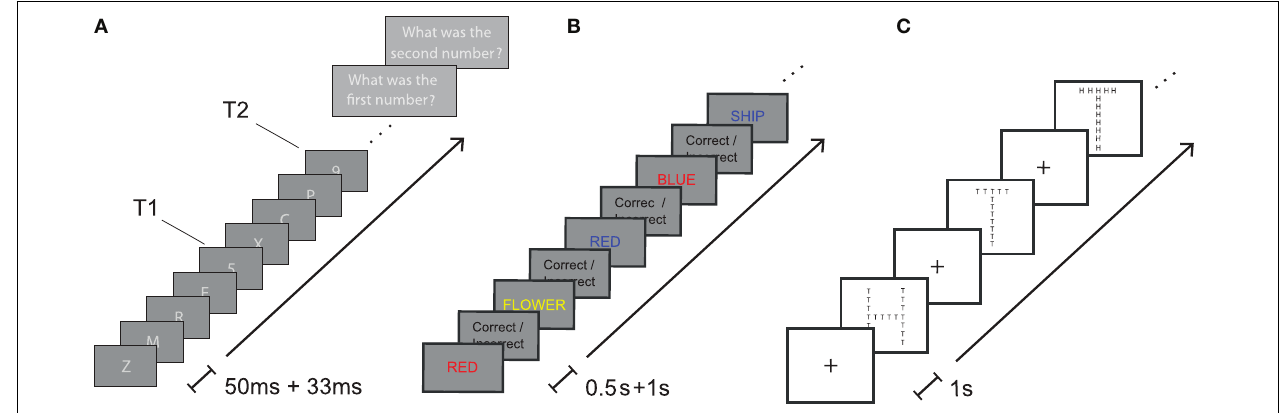
FIGURE 1 | Task paradigms. (A) Attentional blink (B) Stroop task (C) Global-local